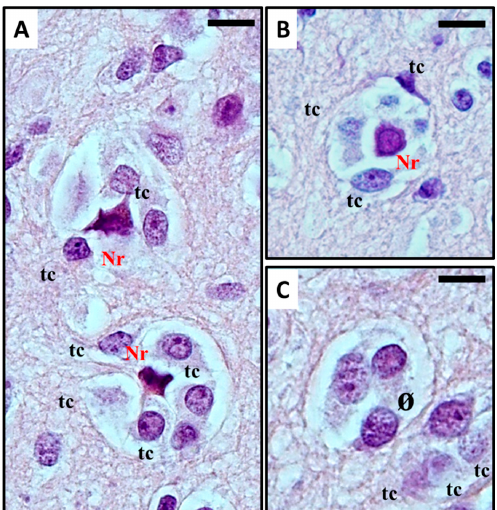
Figure 1. ( A–C ) Histological observation of perineural satellitosis in glioblastoma. Haematoxylin and eosin stain show ( A ) Anaplastic, frankly malignant glial tumour cells (tc) induced neuronal apoptosis ( B ): only the picnotic remnant (Nr) of the neuron remains. In the end, ( C ) the vanishing neuron will be completely replaced by tumour cells (ø). What normally occurs is that neoplastic cells surround the neuronal cell body, which then results in neuronal cell death with intracellular degenerative change and appearance of ‘ghost cells’ surrounded by the neoplastic cells in electron microscopy studies. The neoplastic cells can also phagocytose the remains of the neurons. For detailed information refer to [11,12]. Original images are collected at 400 × magnification and relative region of interest (ROI) is reported. The scale bars are 20 µ